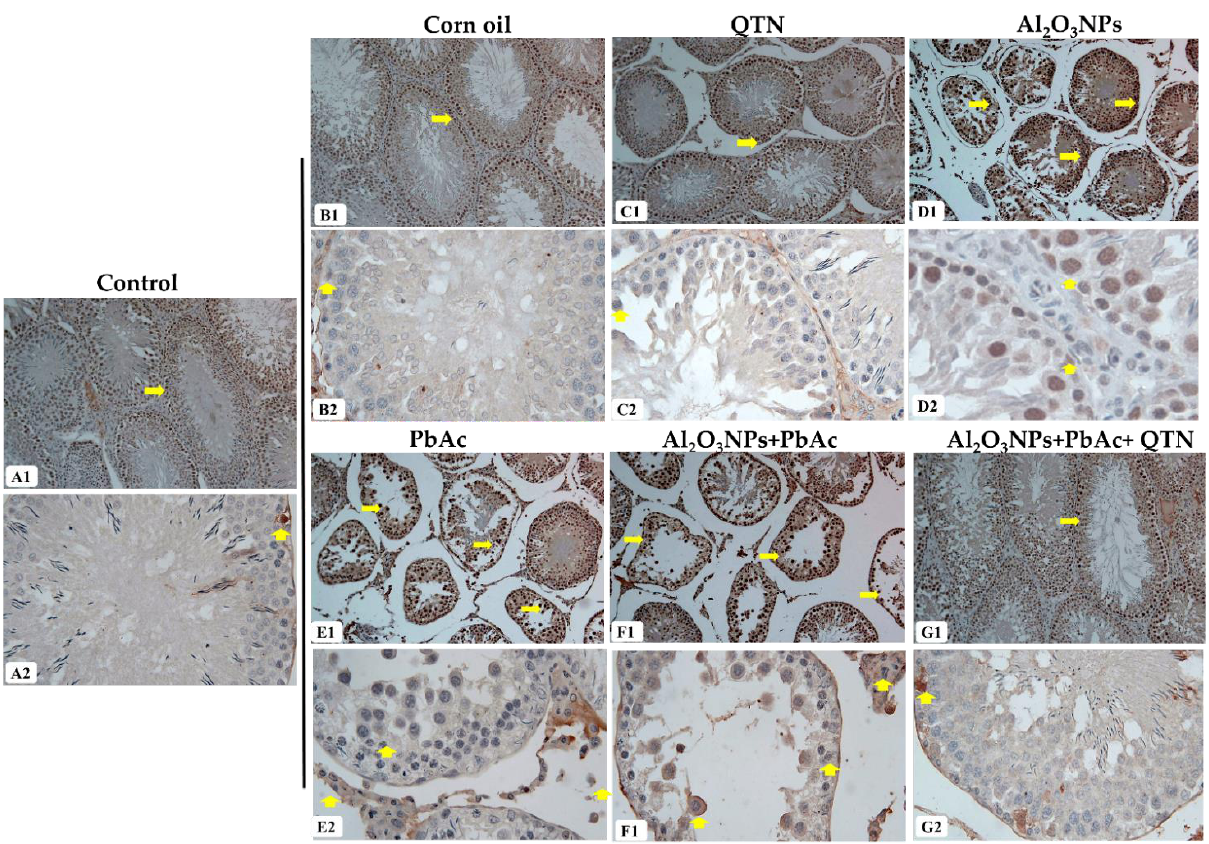
Figure 6. ( A ) Testis of the control rat showing weak TNF- α immuno -stain in the cytoplasm of few Figure 6. ( A1 , A2 ) Testis of the control rat showing weak TNF- α immuno-stain in the cytoplasm of spermatogenic cells. ( B ) Testis of corn oil-treated rat showing weak expression for TNF- α. ( C ) Testis few spermatogenic cells. ( B1 , B2 ) Testis of corn oil-treated rat showing weak expression for TNF- α . of QTN-treated rat showing weak immuno-labeling of some spermatogenic cells. ( D ) Testis of ( C1 , C2 ) Testis of QTN-treated rat showing weak immuno-labeling of some spermatogenic cells. Al 2 O 3 NPs-exposed group showing numerous positive spermatogenic cells and Leydig cells repre- ( D1 , D2 ) Testis of Al 2 O 3 NPs-exposed group showing numerous positive spermatogenic cells and sented by brown color. ( E ) Testis of the PbAc-exposed group showing a strong positive reaction in Leydig cells represented by brown color. ( E1 , E2 ) Testis of the PbAc-exposed group showing a the cytoplasm of spermatogenic cells and Leydig cells. ( F ) Testis of Al 2 O 3 NPs and PbAc co-exposed strong positive reaction in the cytoplasm of spermatogenic cells and Leydig cells. ( F1 , F2 ) Testis of group showing strong positive TNF- α immuno -stain ( G ) Testis of Al 2 O 3 NPs and PbAc co-exposed Al 2 O 3 NPs and PbAc co-exposed group showing strong positive TNF- α immuno-stain ( G1 , G2 ) Testis and QTN-treated group showing weak TNF- α positive cells (TNF- α immuno -stained, ×100 for A1- G1 and ×400 A2 – G2). of Al 2 O 3 NPs and PbAc co-exposed and QTN-treated group showing weak TNF- α positive cells (TNF- α immuno-stained, × 100 for ( A1 – G1 ) and × 400 ( A2 – G2 )). Yellow arrows denoted TNF- α -positive immune stained